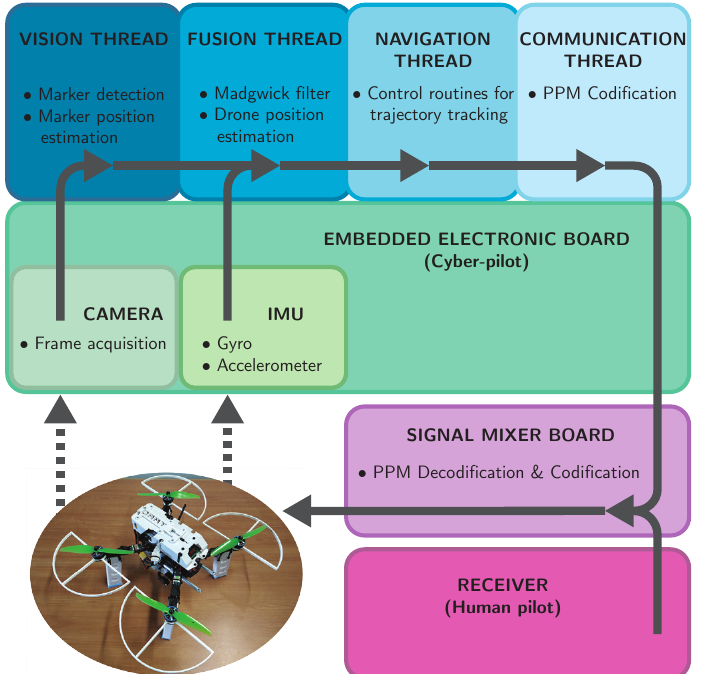
Figure 12. The core of the software stack is composed of four task. The vision thread is responsible for the marker detection and its position estimation from the frames acquired by the on-board camera. Its output is processed along with data from the IMU by a Madgwick filter whose aim is estimating the drone position. This latter information is then processed by the navigation thread which performs the control routines to keep the estimated trajectory as close as possible to the desired one. The navigation thread output are reference points which are transmitted to the low-level flight controller by the signal mixer, which also handles the commands of the human pilot coming from the receiver. The detailed information flow across vision and fusion threads is depicted in Figures 8–10, while that of the navigation thread is shown in Figure